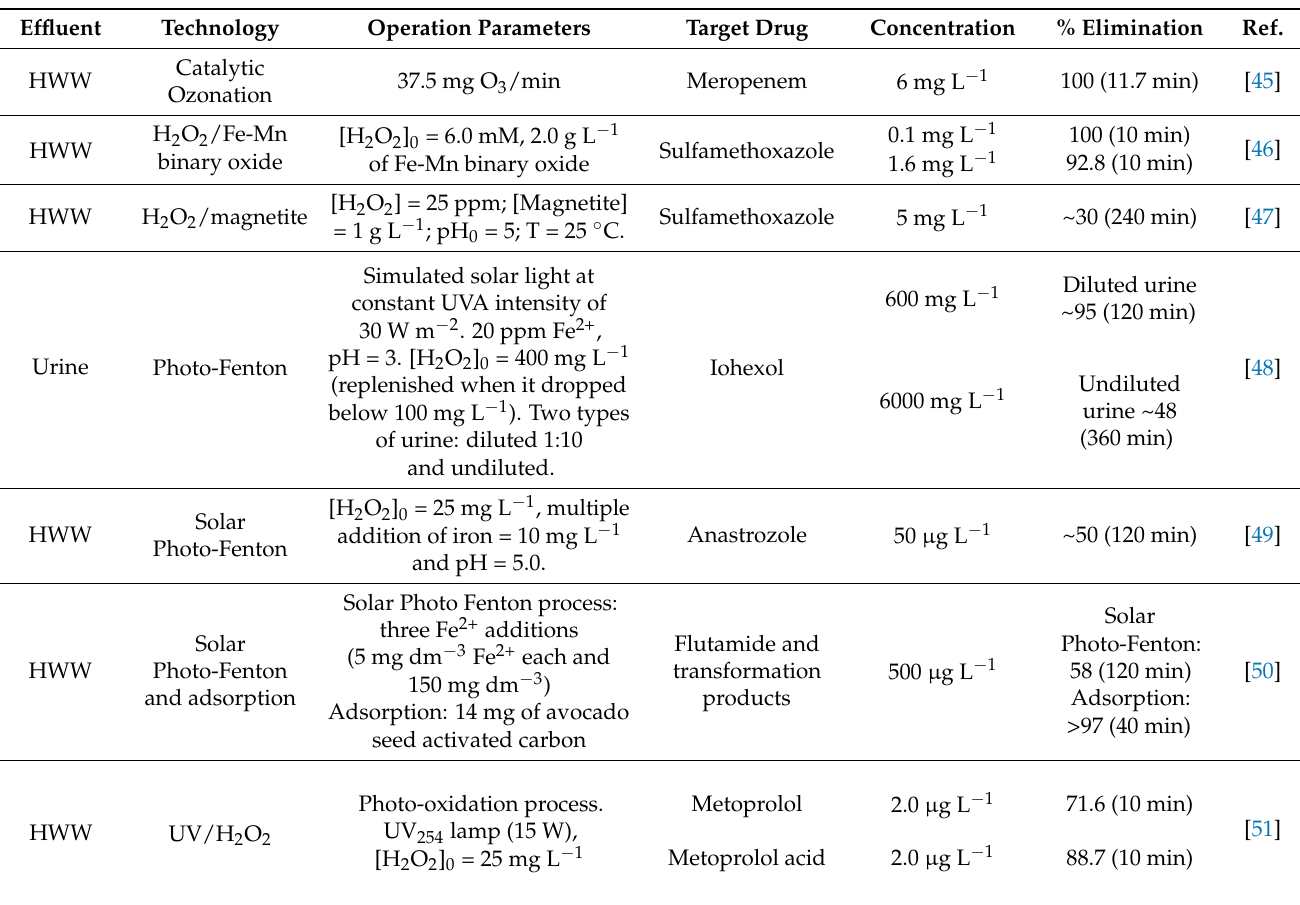
Table 3. AOPS for the removal of PhCs in